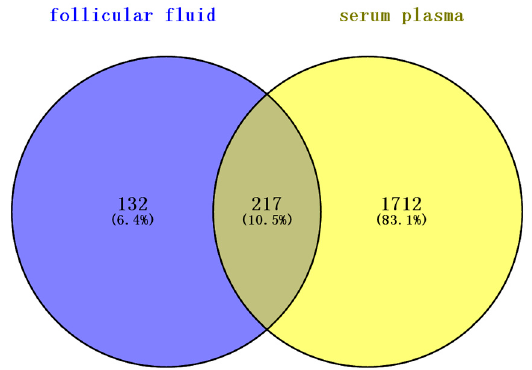
Figure 6. Overlapping analysis of proteins in follicular fluid and serum plasma.